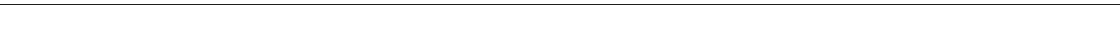
Fig. 4 GCSF disrupts cDC1 differentiation. a Blood and BM serum cytokines in orthotopic PyMT-B6 end-stage tumor-bearing mice relative to tumor-free controls; tumor-free, n = 6; PyMT-B6, n = 7. b GCSF in human BC patient blood serum relative to healthy controls; healthy controls, n = 30; BC, n = 42. c Number of BM pre-DCs, CD24 + cDC1s, and immature granulocytes; numbers of blood pre-DCs and granulocytes, and tumor CD8 + T cells (CD45 + CD3 + CD8 + ) in tumor-free mice, orthotopic PyMT-B6 tumor-bearing end-stage mice, and orthotopic PyMT-B6 tumor-bearing end-stage mice treated for 2 weeks with 50 μ g anti-GCSF IgGs 3 × /week; n = 5 – 7/group. Data are representative of two independent experiments. d Number of BM MDPs, CDPs, pre-DCs, CD24 + cDC1s, and immature granulocytes, and number of blood pre-DCs and granulocytes in C57BL/6 mice treated with 2 μ g GCSF for 10 days; n = 6/group. Data are representative of two independent experiments. e CD45.2 + Lin − Sca1 − cKit + MPs, MDPs, and CDPs isolated from tumor-free mice were cultured on CD45.1 + BM feeder culture in the presence of 100 ng/ml Flt3L, 100 ng/ml GCSF, or 100 ng/ml Flt3L and 100 ng/ml GCSF for 5 days. Final cultures were analyzed for cDC1s (Live CD45.2 + CD45.1 - MHCII + CD11c + Sirp α - CD24 + ) and granulocytes (Live CD45.2 + CD45.1 - CD11b + Ly6G + ). Data are representative of three independent experiments consisting of three wells per condition. f Experiment similar to that in Fig. 4d, but CD45.2 + cells were pre-treated with 100 ng/ml GCSF or media alone for 24 h prior to plating on CD45.1 + BM feeder layer. Data are representative of two independent experiments consisting of three wells per condition. End stage for each model is de fi ned in the Methods. Error bars represent mean + / − s.e.m. or box plot; * p < 0.05, ** p < 0.01, *** p < 0.001 by unpaired two-sided Student ’ s t